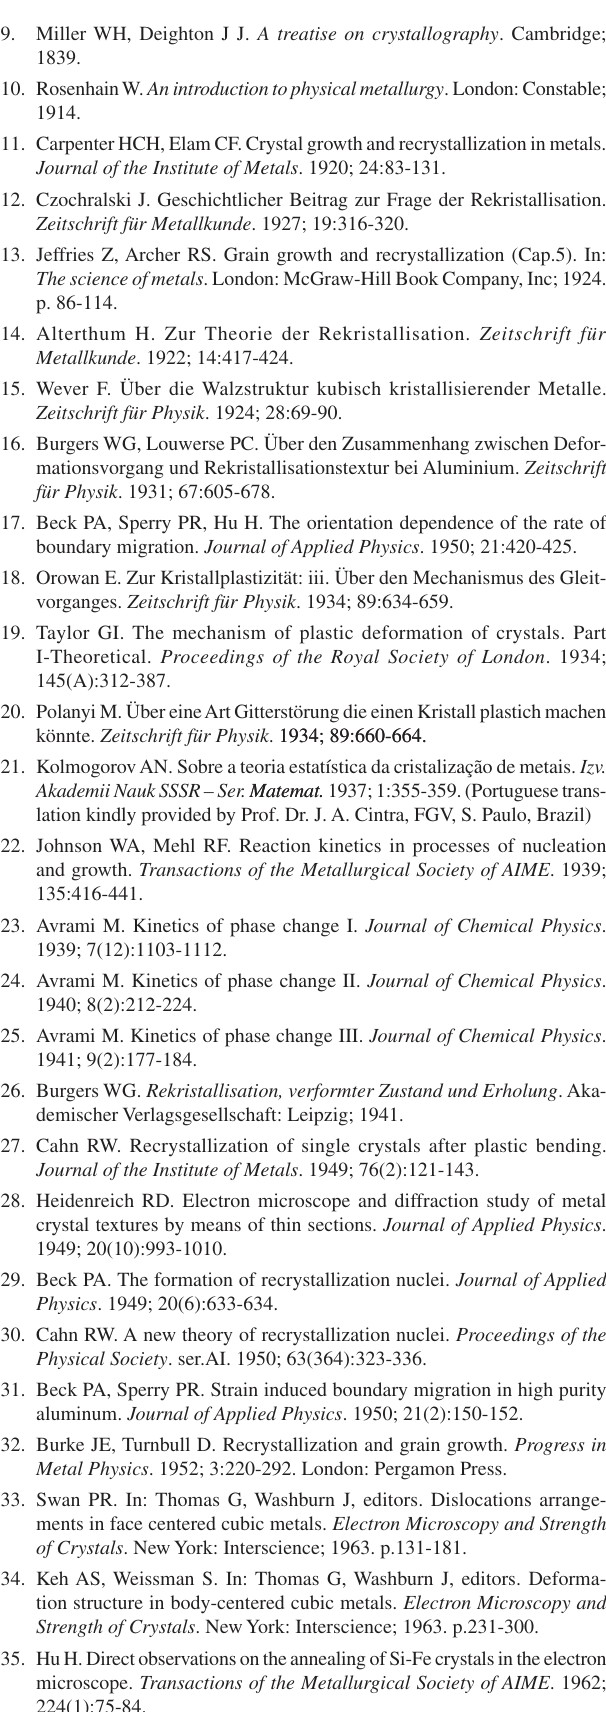
) with annealing CH